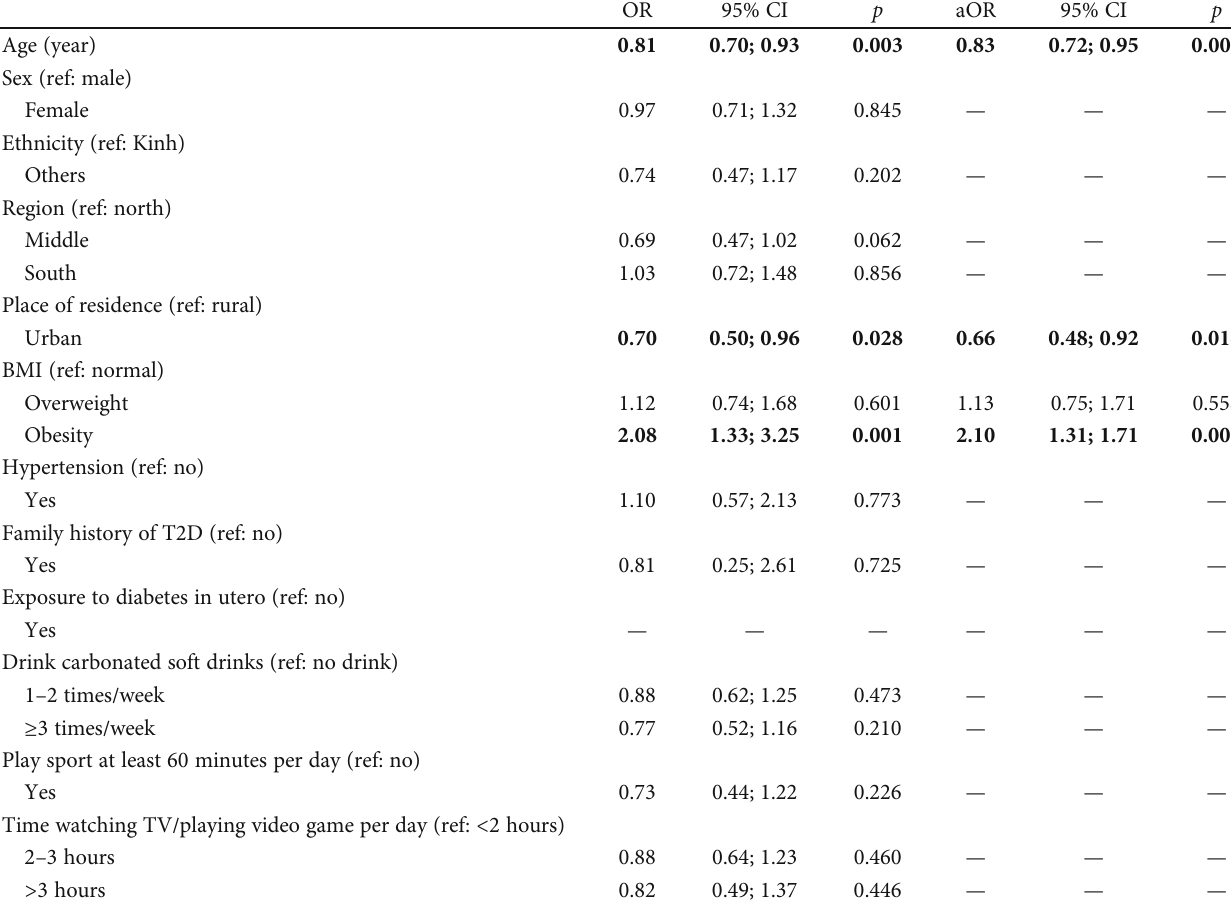
Table 4: Factors related to impaired fasting